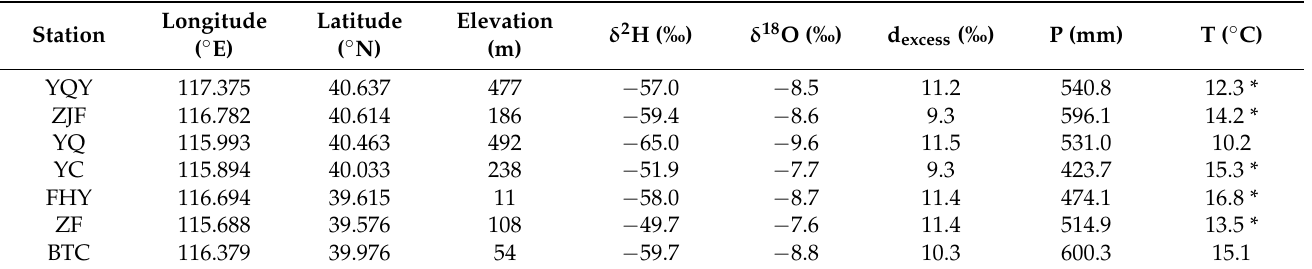
Table 1. BNIP station locations, annual precipitation amount, annual mean temperature, and mea- sured annual mean precipitation isotopic